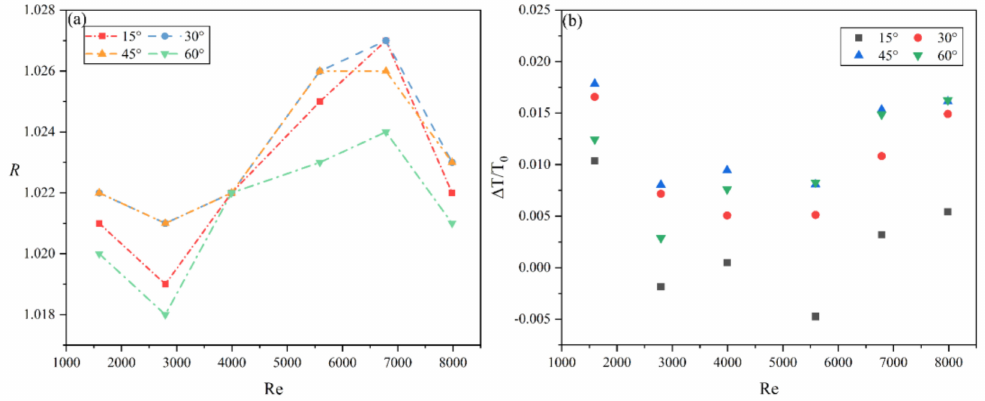
Figure 4. Performance of ( a ) R and ( b ) thermal enhancement factor ∆ T When the iterative error is less than 10 − 5 and the maximum temperature does not